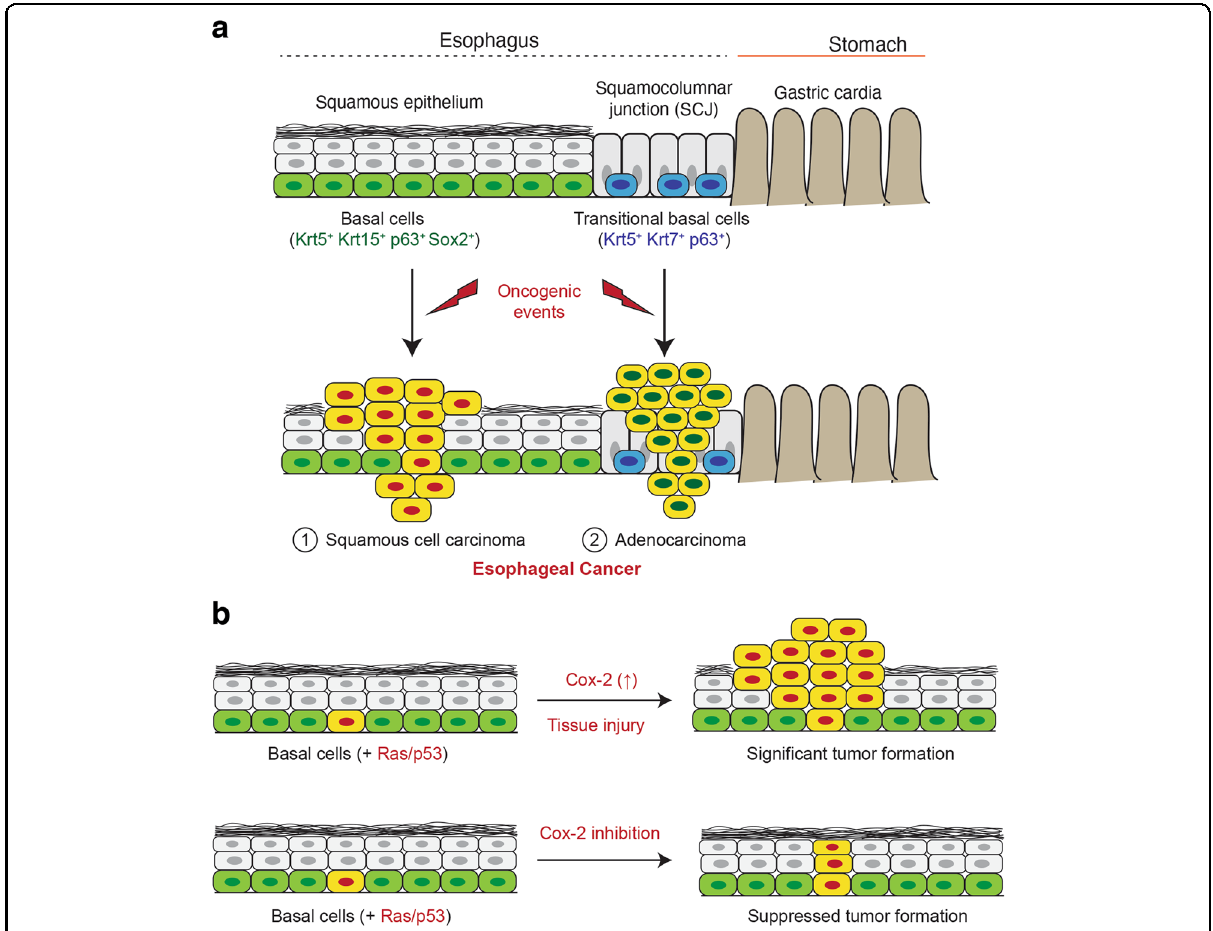
Fig. 2 The role of Cox-2 in foregut basal stem/progenitor cells during the earliest stages of SCC formation. a Cellular diversity and anatomical distinctions between esophageal SCCs and Barrett ’ s adenocarcinoma. While SCCs are known to arise from basal stem/progenitors within the squamous epithelium, the cellular origins of Barrett ’ s adenocarcinoma could be variable. Examples include Krt7-positive transitional basal cells and residual embryonic stem cells at the squamous columnar junctional regions. b Cox-2 can be upregulated by cellular extrinsic stress factors such as smoking and gastric acid re fl ux, which in turn accelerate tumorigenesis. However, Cox-2 inhibition can signi fi cantly suppress tumor formation from tumor-prone basal stem/progenitor cells and has features that support a more differentiated cell